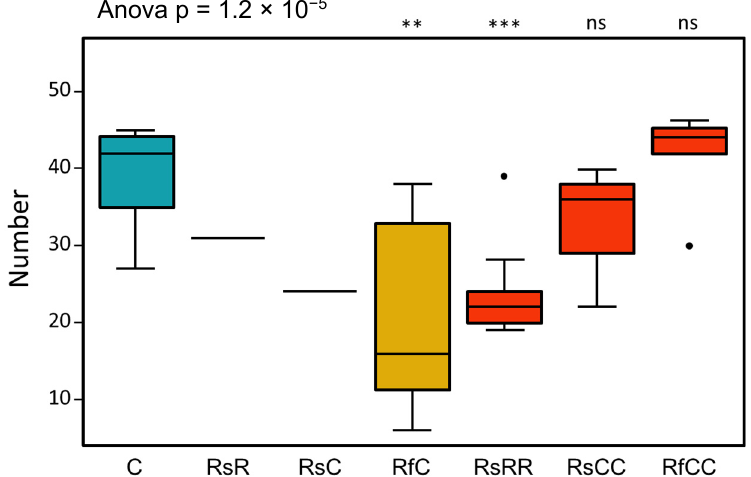
Figure 3. Number of nymphs per ootheca. ANOVA test comparing all the samples as a global p -value shown in the top left, t-test values comparing each experimental sample to the control shown above the bars (ns, p > 0.05; **, p <= 0.01; ***, p <= 0.001). T-test comparisons could not be performed in samples RsR and RsC due to the small number of replicates (under three), because a single ootheca hatched in these conditions. Blue box, control; yellow boxes, G2; red boxes, G3.